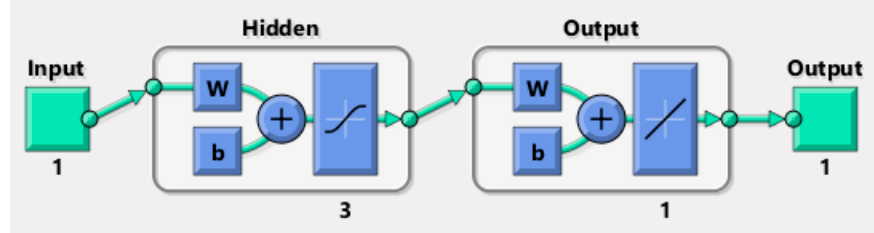
Figure 8. Diagram of the ANN model for THL, where w represents the ANN weights and b represents bias, Input is the fabric property thickness and Output is THL.